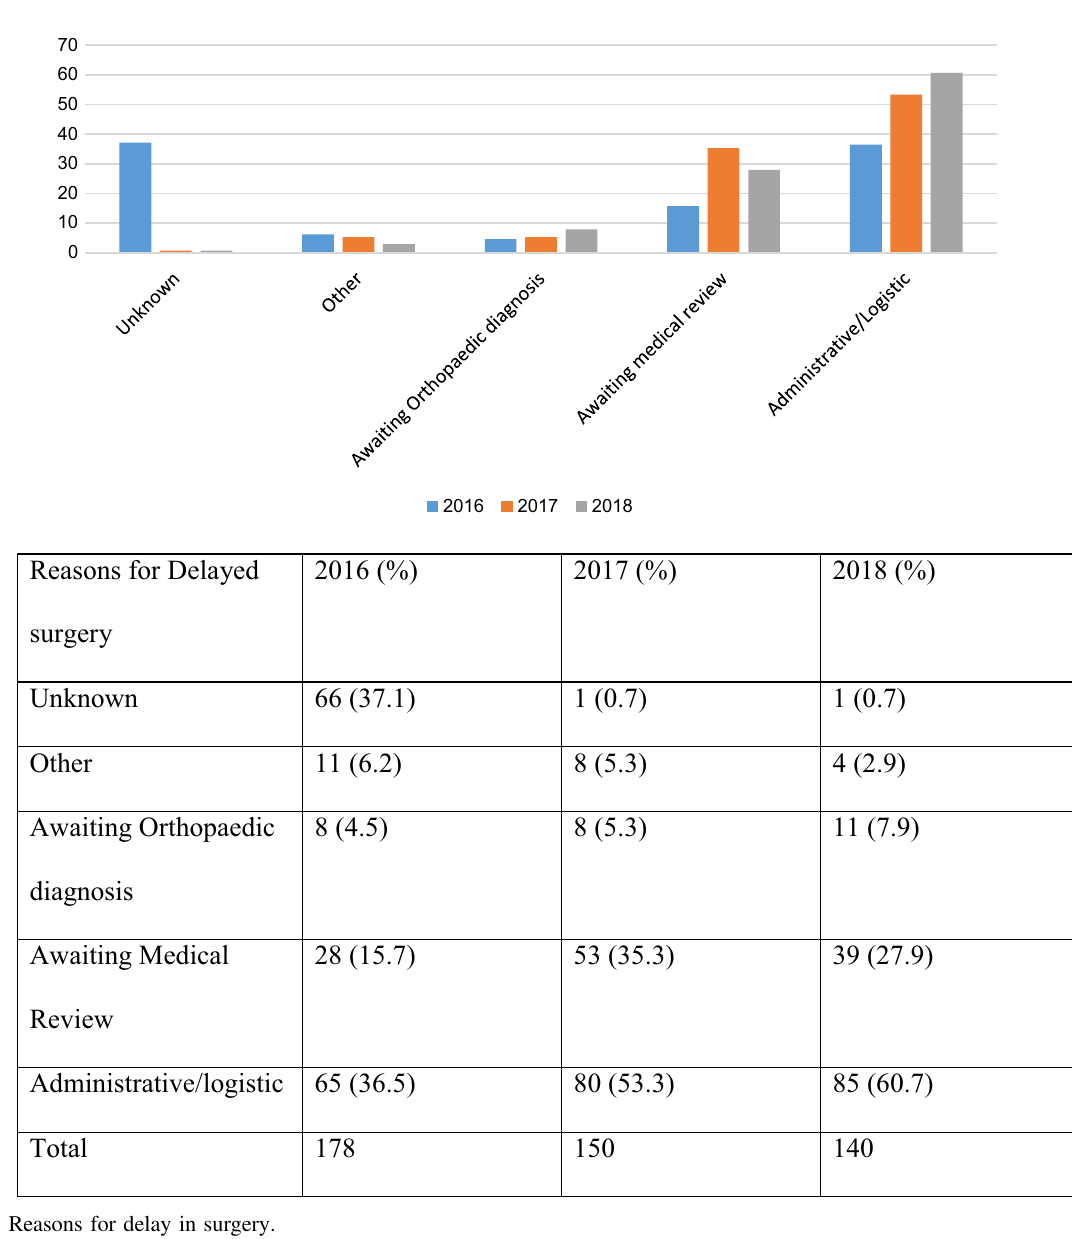
Figure 3. Reasons for delay in